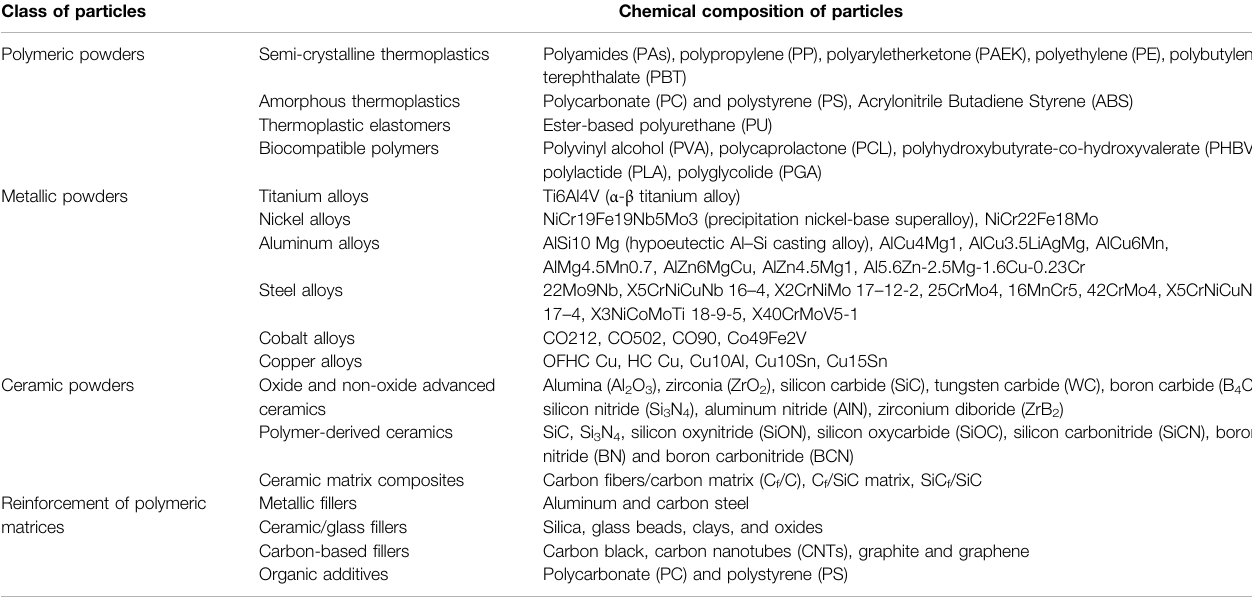
TABLE 1 | Chemical composition of powder particles applied in the AM industry-- > Class of particles/Chemical composition. Class of